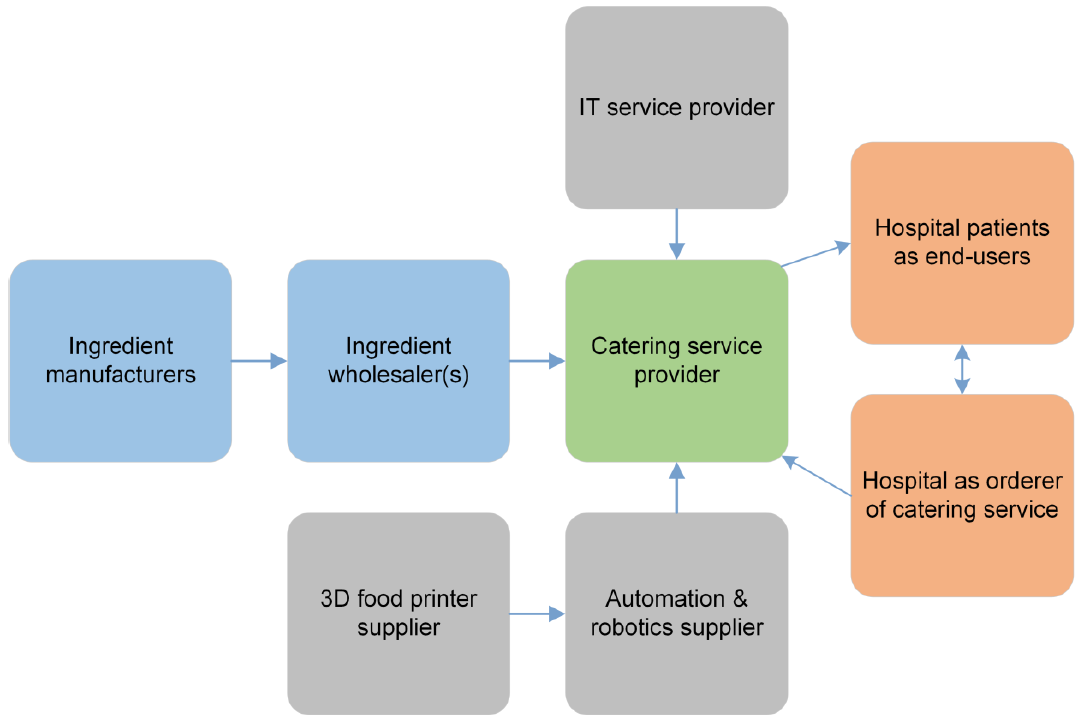
Figure 10. Value chain of business model—3D food printing in kitchen department of